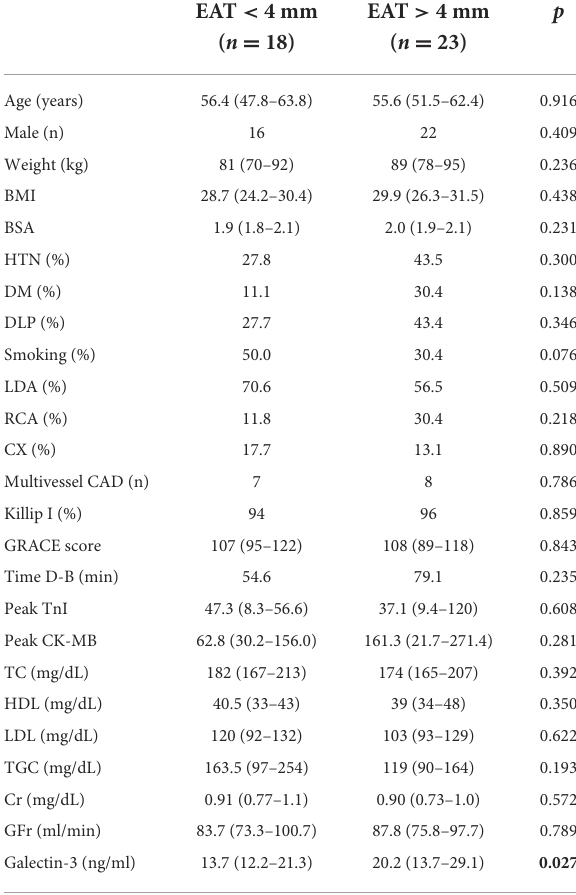
TABLE 1 Baseline clinical